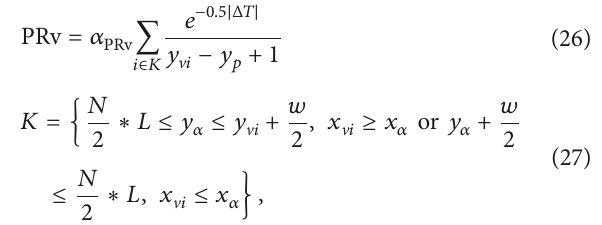
1, although the time gap is small in lane 3, pedestrians will still choose to cross the vehicle traffic flow in lane 1, because pedestrians assume that the cars in lane 3 have passed the conflict points when they arrive at lane 3. To make stop/go decision-making model more reasonable, threats from cars in different lanes should be taken into consideration. The first approaching car in every lane at the same half of the road with pedestrians is chosen to calculate the total perceived risk from cars. Among these approaching cars, the headmost vehicle in the nearest lane has the largest weight. After the headmost car has passed a pedestrian, the next car in the same lane becomes the new car to be